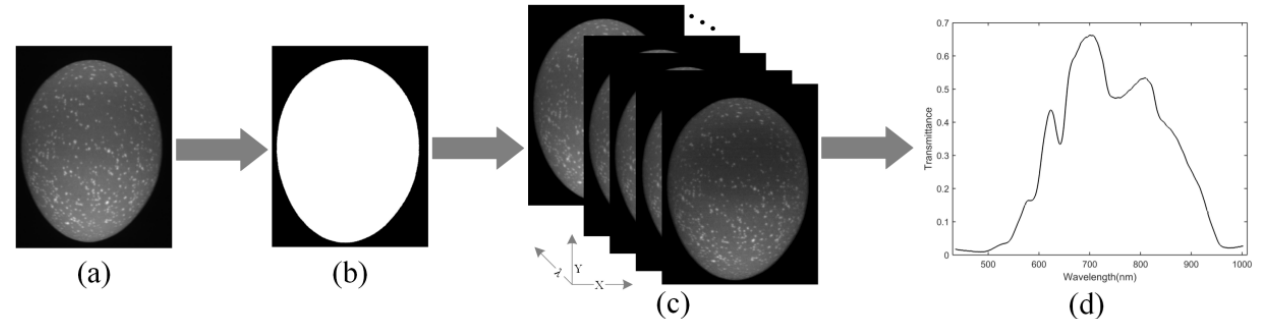
Figure 2. Spectral data extraction of ROI ( a ) Image at 700.4 nm; ( b ) binary mask image; ( c ) result of ROI identification; ( d ) mean spectral curve of ROI.